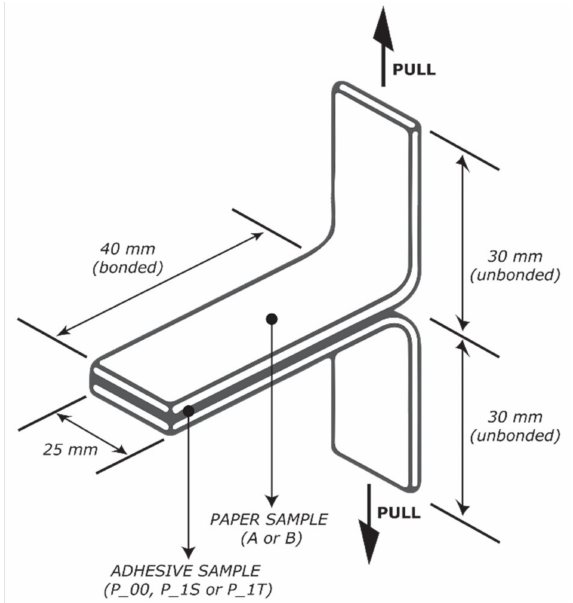
Figure 2. Schematic representation of T-peel test